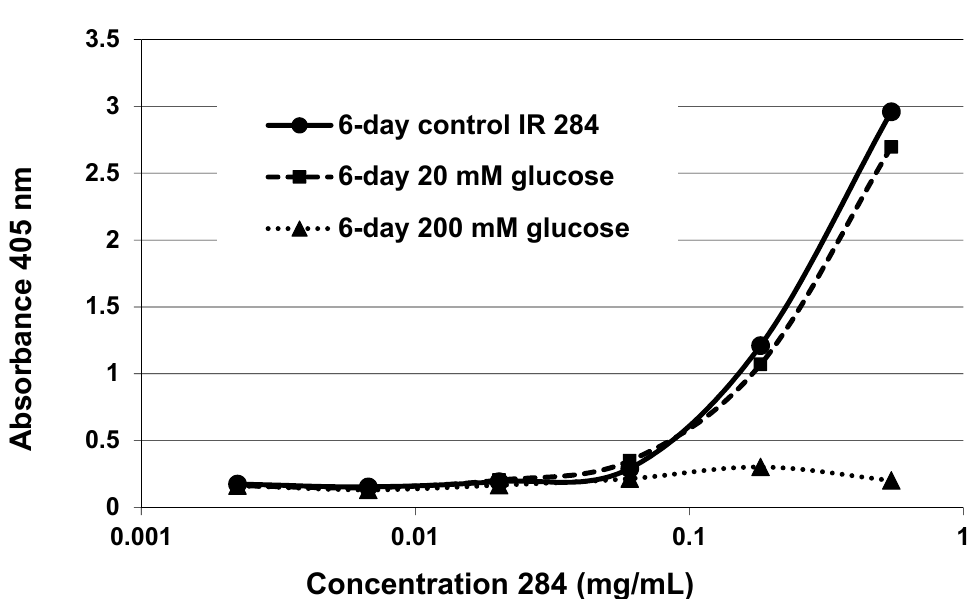
Figure 11. Insulin-HRP binding to insulin receptor (IR) 284–298 in the absence and presence of glucose over six days. 20 mM glucose incubation had a negligible effect on insulin-HRP binding, while 200 mM glucose shifted the curve dramatically to the right.